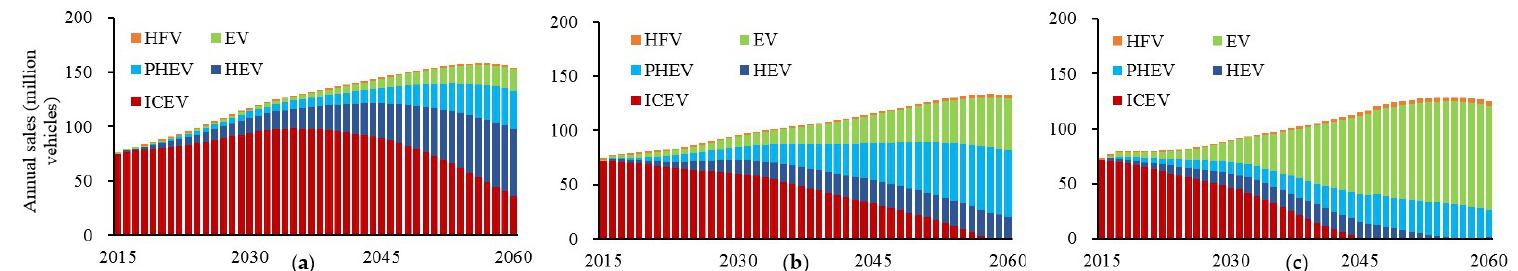
Figure 6. Annual Next-generation vehicle sales. ( a ) RTS ( b ) 2DS ( c ) B2DS.